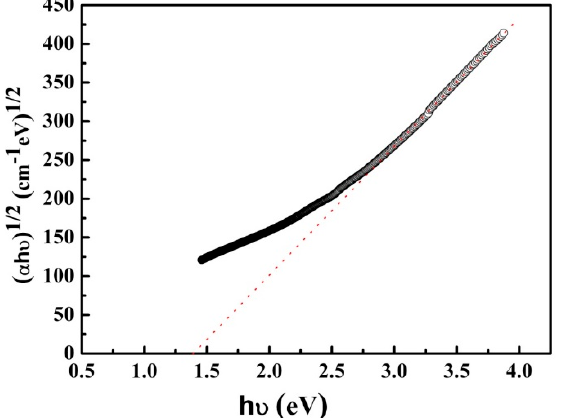
Figure 6. Plot of ( α h ν ) 1/2 versus h ν profile of a representative AlSb:Zn film deposited at 400 °C.